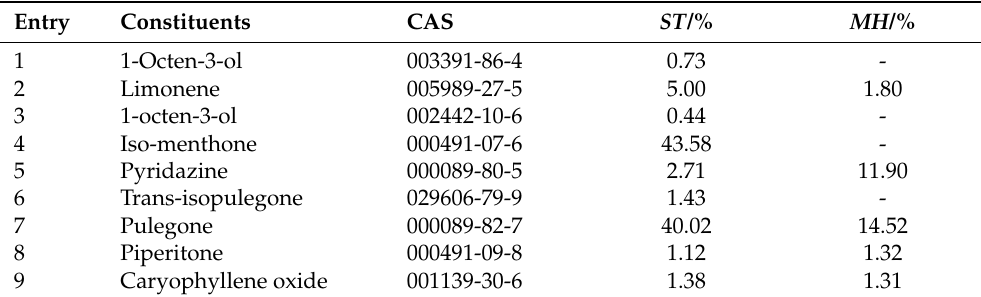
Table 1. Quantitative analysis of volatile oil of ST and MH [5].